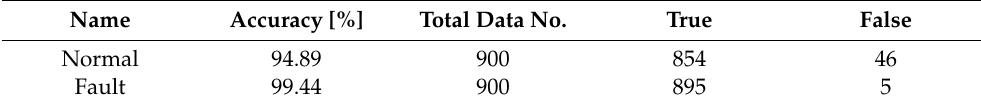
Table 4. Accuracies according to the sound conditions.